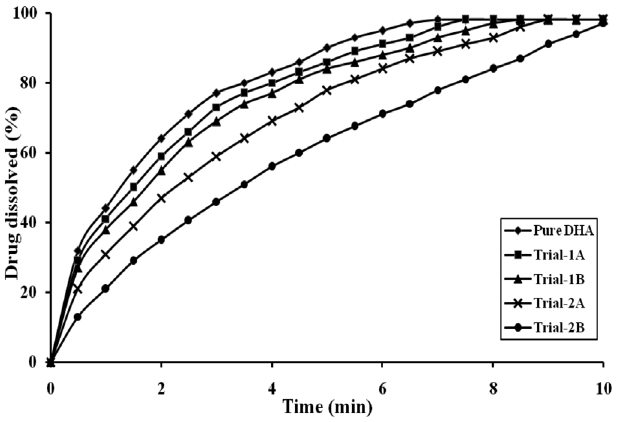
FIGURE 3 - In vitro dissolution profile of DHA granules.